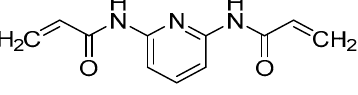
KPS Figure 6. Structures of commonly used initiators in free radical polymerization.